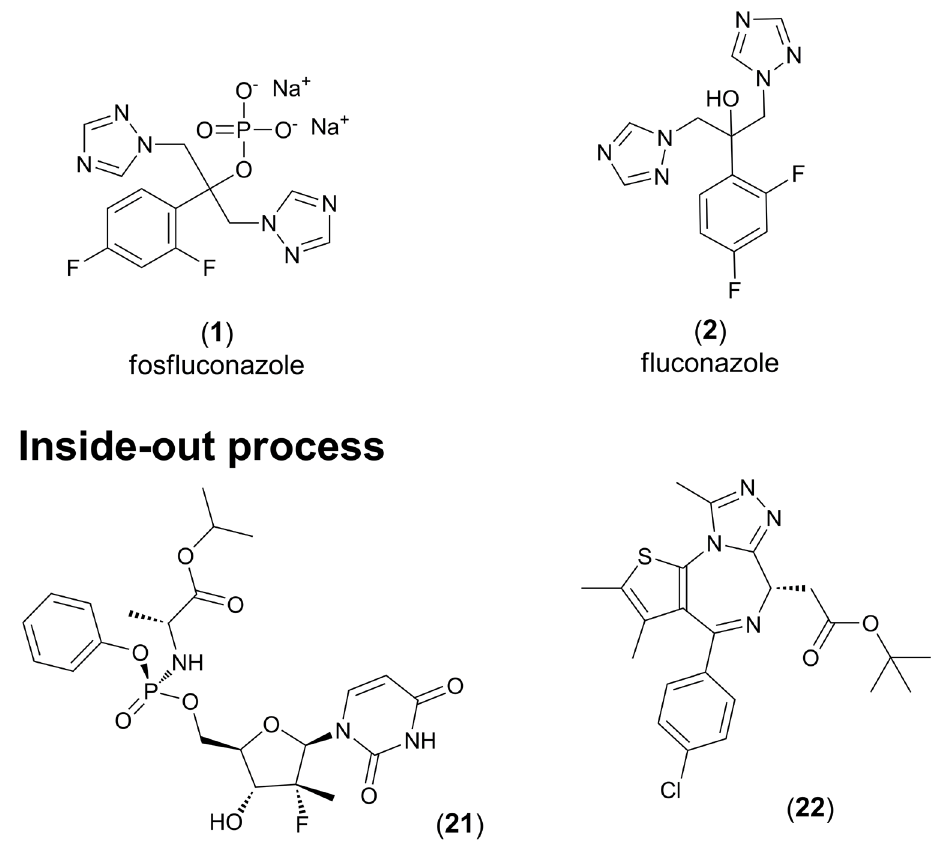
FIGURE 1 - Chemical structures of fosfluconazole (1), fluconazole (2), sofosbuvir (21) and JQ-1 (22).